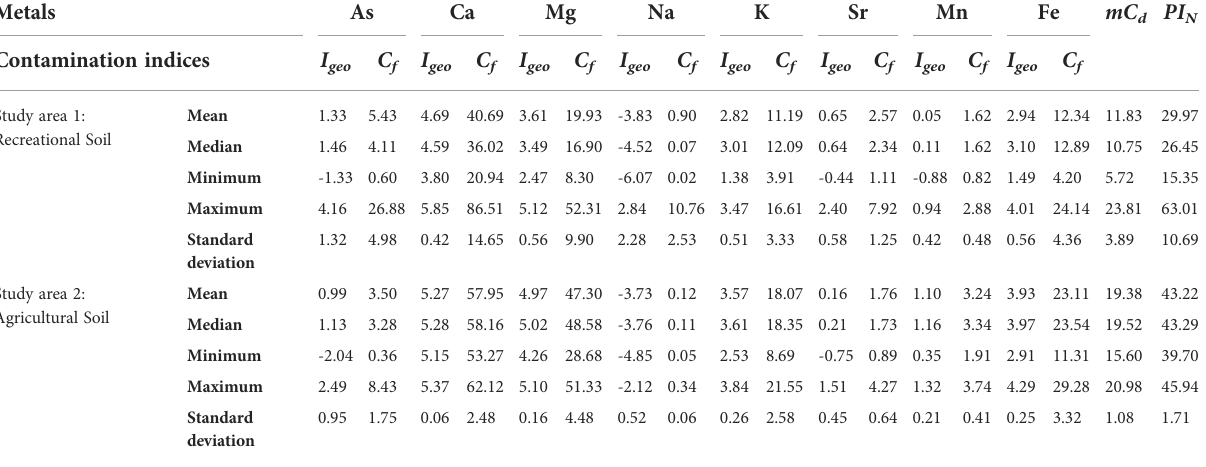
TABLE 3 The metal contamination and risk assessment by different types of contamination indices. Metals